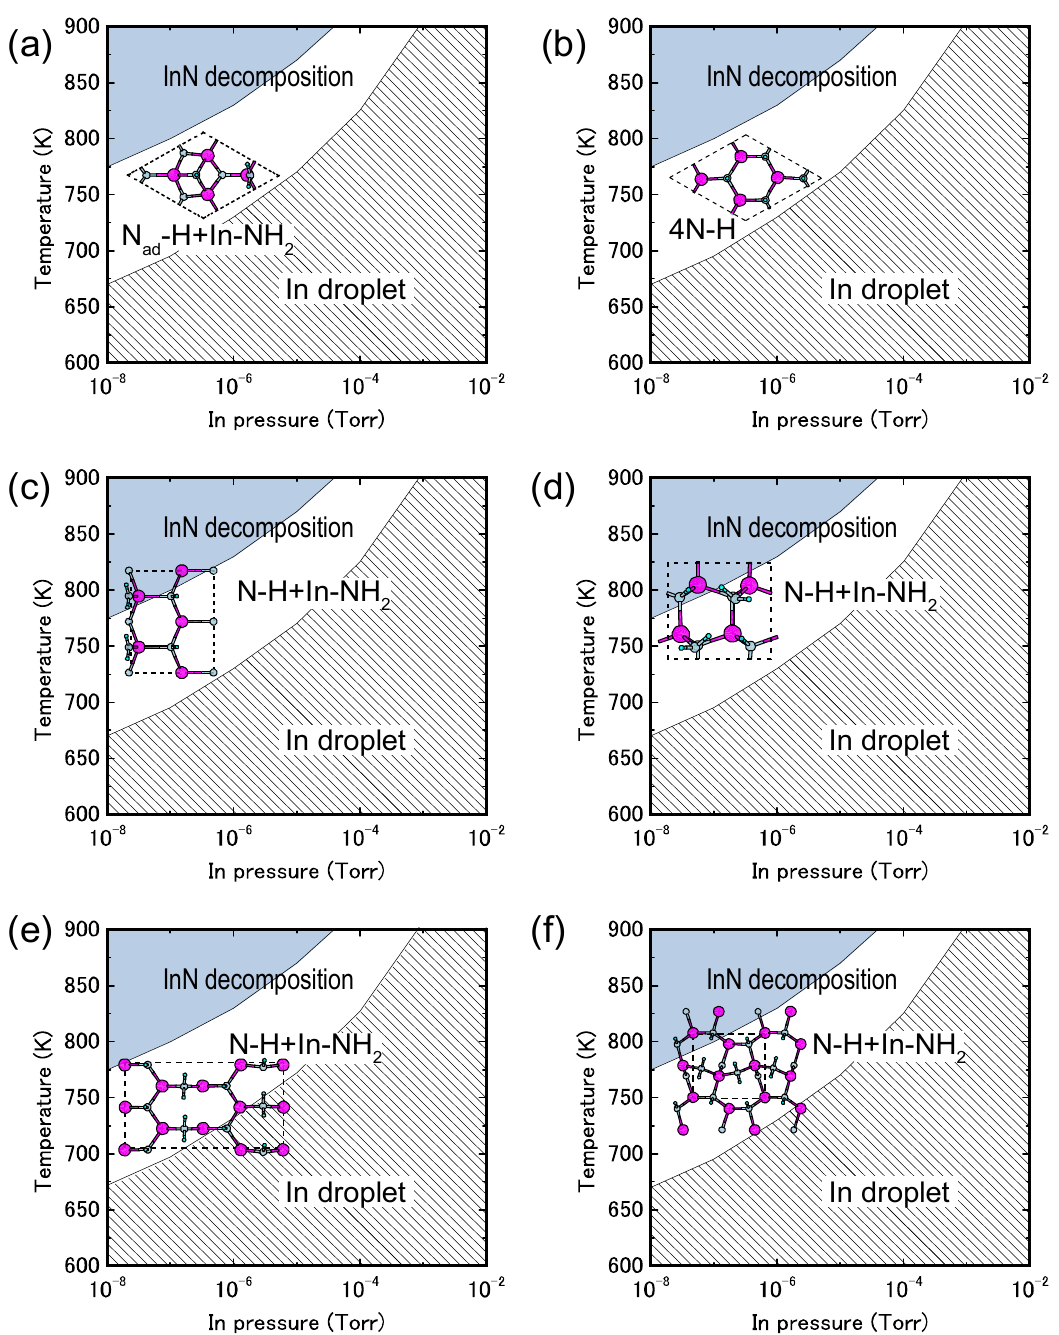
Figure 28. Calculated H-adsorbed InN surface phase diagrams for polar ( a ) (0001) and ( b ) (cid:4666)0001(cid:3364)(cid:4667) , nonpolar ( c ) (cid:4666)11(cid:3364)00(cid:4667) and ( d ) (cid:4666)112(cid:3364)0(cid:4667) , and semipolar ( e ) (cid:4666)11(cid:3364)01(cid:4667) and ( f ) (cid:4666)112(cid:3364)2(cid:4667) orientations as a function of temperature and In BEP under high H ( p = 76 Torr) conditions. Top surface structure views are also presented. Large, small, H2 and tiny circles represent In, N, and H atoms,